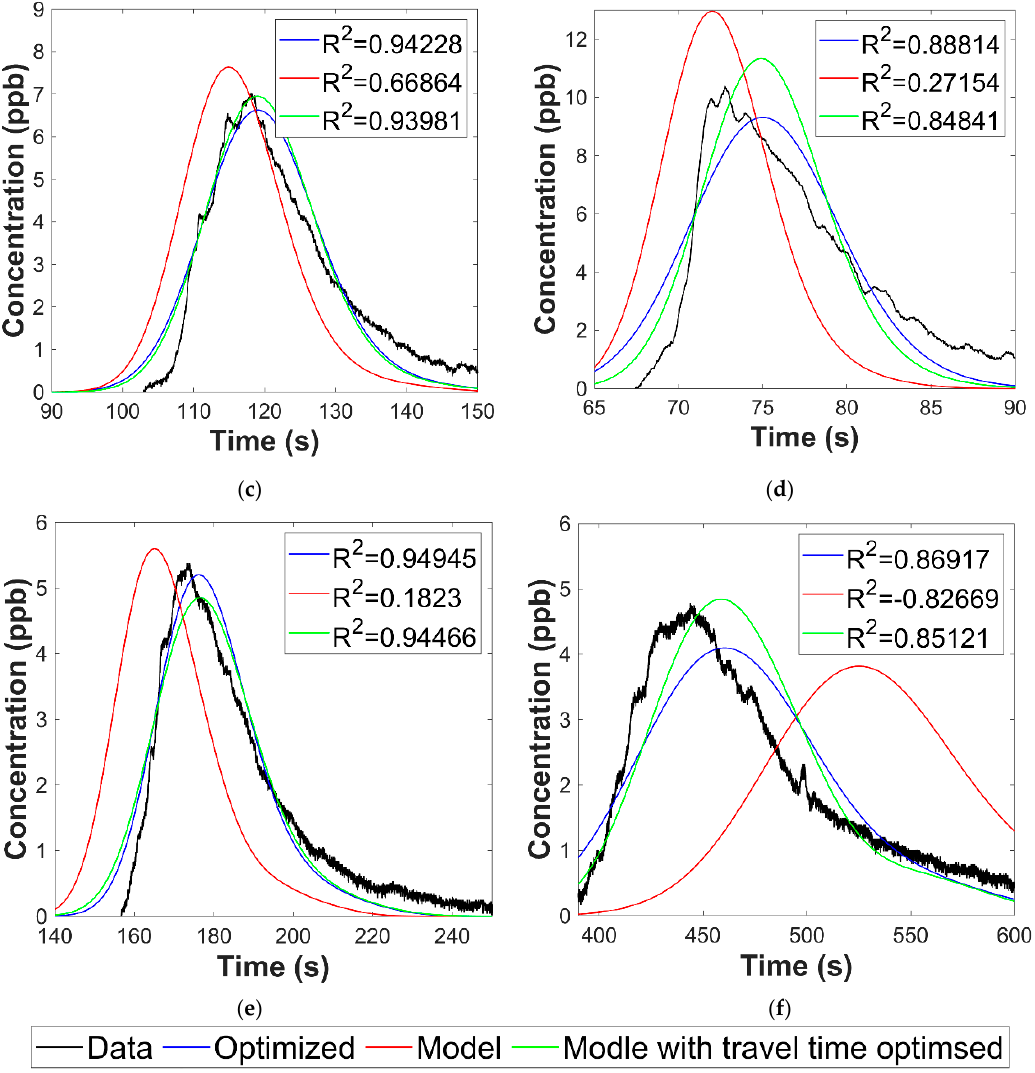
Figure 11. Examples of comparisons between down-stream data (black line), predicted down-stream profile from the model (red line), prediction with optimized values (blue line) and prediction using the model, but with travel time held at the optimized value (green line). Case and levels are selected to give a range of representative correlation value examples. ( a ) Case A, level 5, ( b ) Case B, level 2, ( c ) Case C, level 3, ( d ) Case A, level 1, ( e ) Case D, level 5, and ( f ) Case D, level 4.